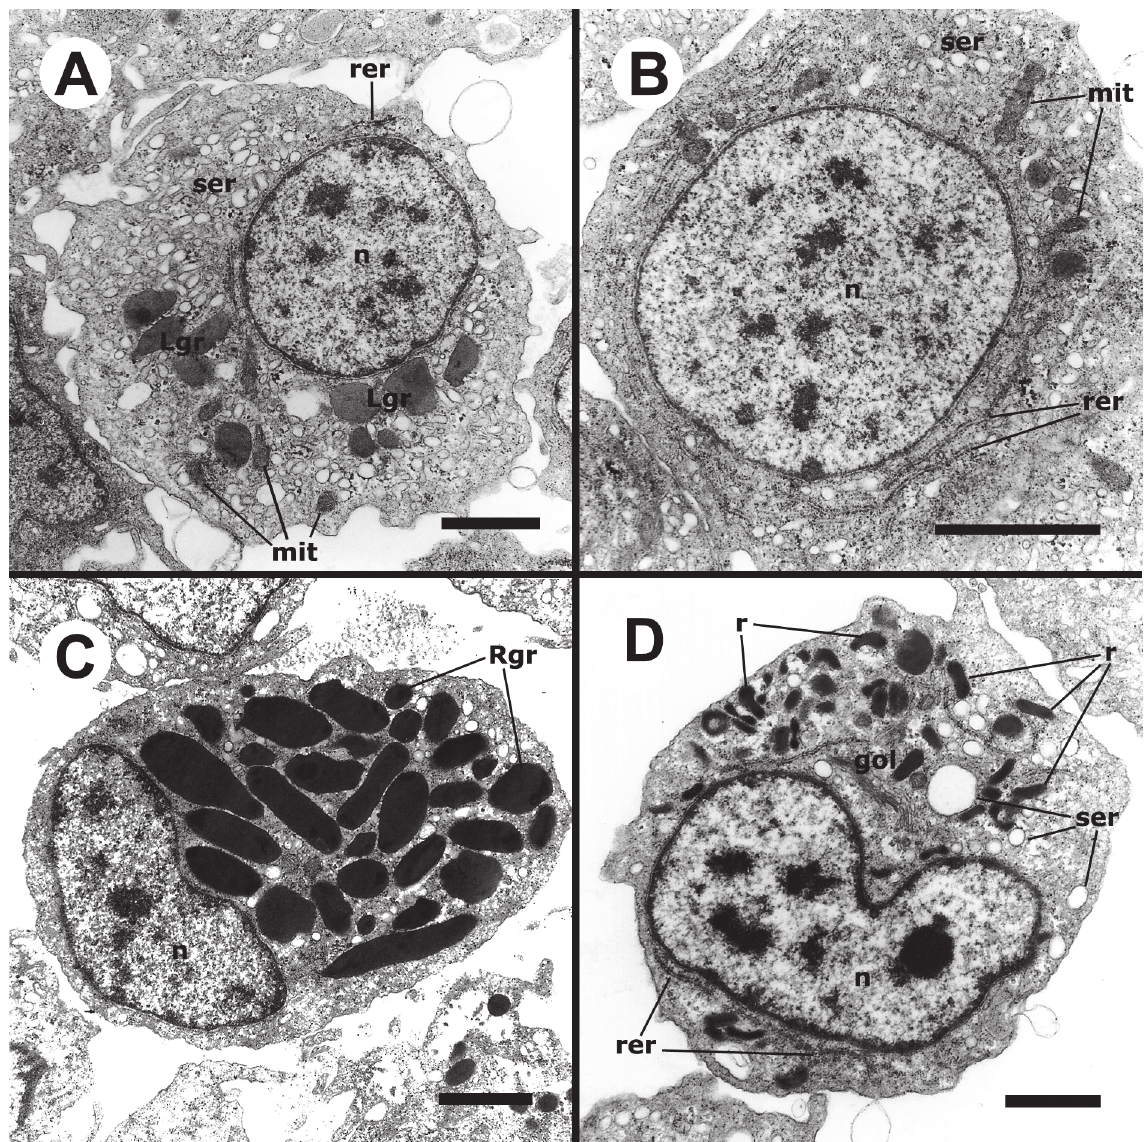
Fig 3. Circulating hemocytes (TEM). (A) Hyalinocyte with an eccentric nucleus, numerous SER vesicles, mitochondria and L granules; a few profiles of the RER are also seen. (B) Agranulocyte with a round central nucleus, SER vesicles and RER cisternae, as well as some mitochondria. (C) Granulocyte, showing a displaced, bean-shaped nucleus and numerous R granules; some SER vesicles are also seen. (D) Pro-granulocyte, showing a bean-shaped nucleus, a Golgi complex and numerous immature R granules of varying electron density; some SER vesicles and extended RER cisternae are also seen. Abbreviations: gol , Golgi complex; Lgr , L granules; mit , mitochondria; n , nucleus; r, immature R granules; Rgr , mature R granules; rer , RER cisternae; ser , SER vesicles. Scale bars represent 1 μ